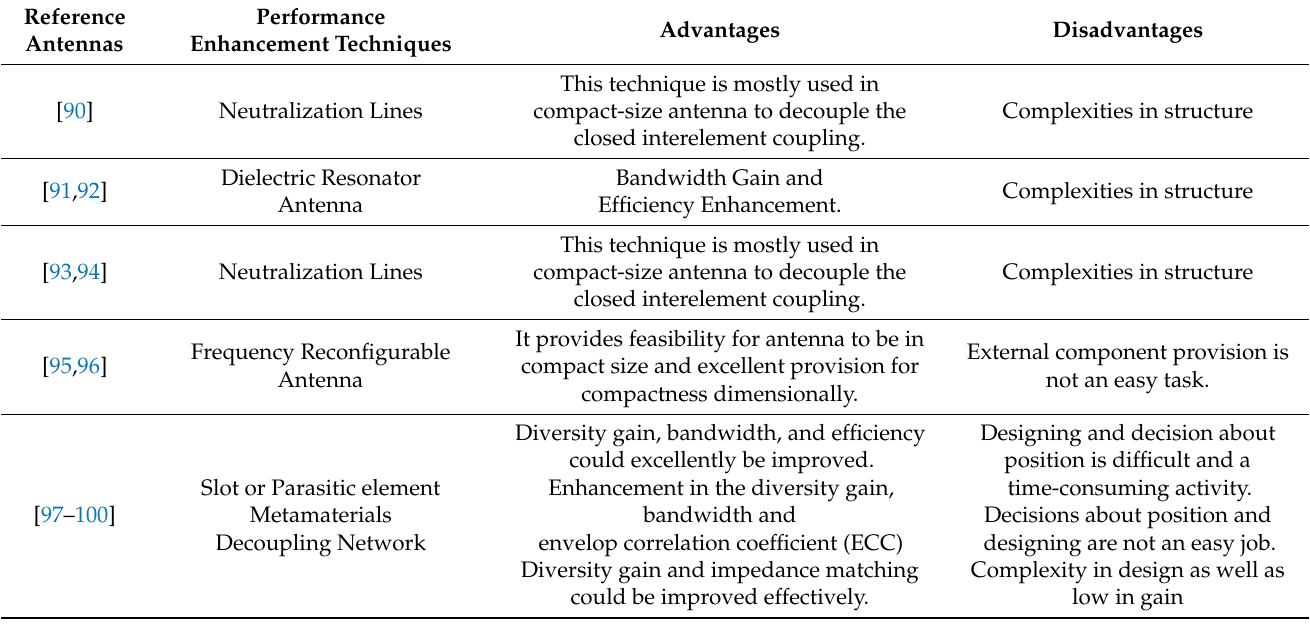
Table 5. Mutual Coupling Reduction/Decoupling Techniques Advantages and